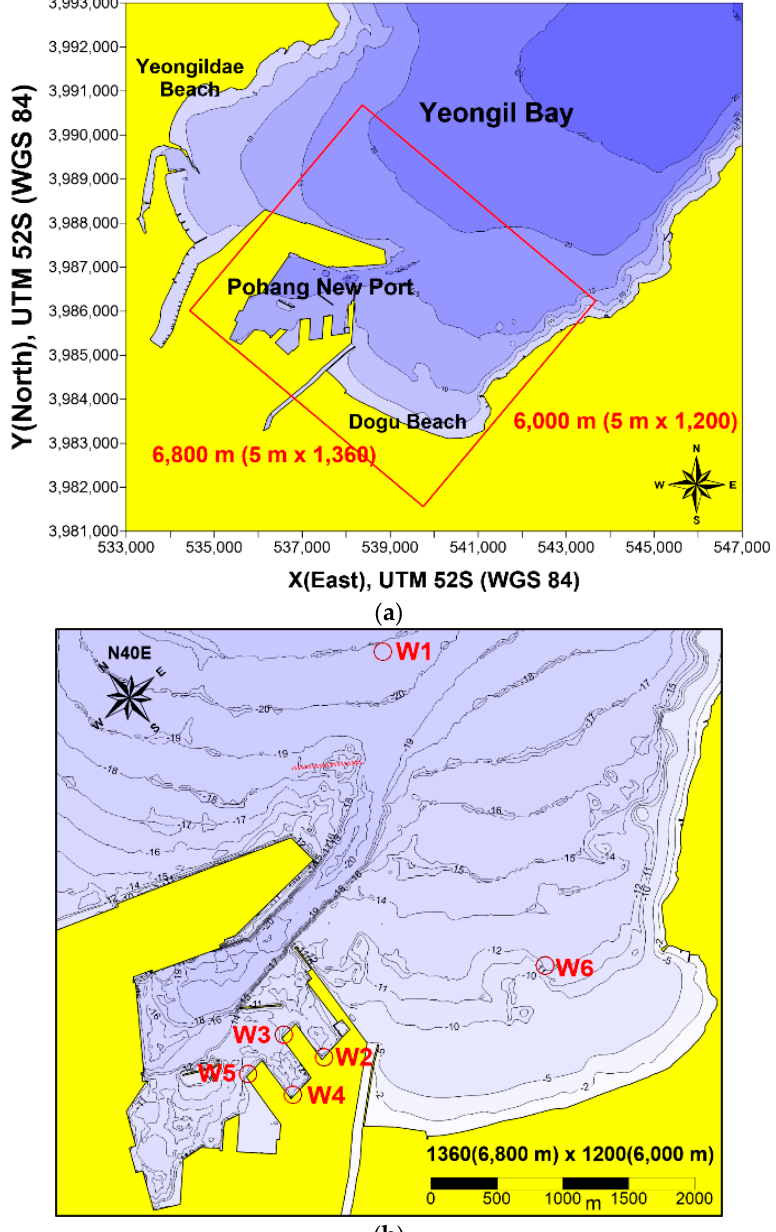
Figure 4. ( a ) Map of Yeongil Bay around Pohang New Port, in which the computational domain for the BOUSS-2D wave model is marked in a red rectangle, ( b ) model domain with the bathymetry map and the locations of wave stations. It is noted that the domain is rotated 40° in the NE direction for the outer open boundary to face N40°E .